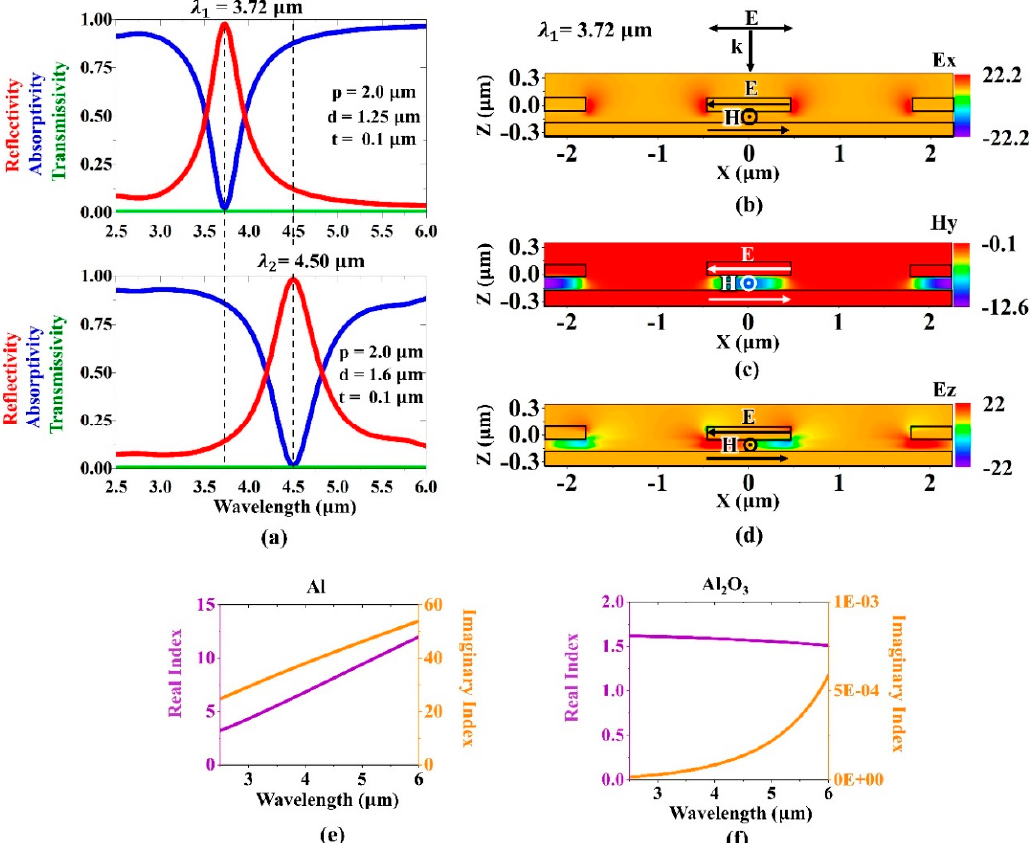
Figure 2. ( a ) Reflectivity, absorptivity, and transmissivity characteristics of the plasmonic perfect absorber at the resonance wavelengths of 3.7 μ m and 4.50 μ m. The simulated amplitude plots of ( b ) electric field in x direction, ( c ) magnetic field in y direction, ( d ) electric field in z direction at the resonance wavelength of 3.7 µ m, illustrates the highly localized characteristics of the plasmonic perfect absorber. The refractive index dispersion data of ( e ) Al and ( f ) Al 2 O 3 used in the simulations was taken from literature